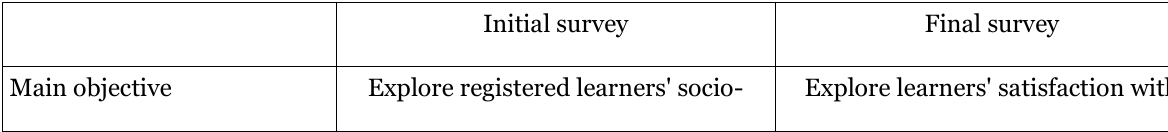
Population, Sample, Objectives and Dates of the Initial and Final MOOC